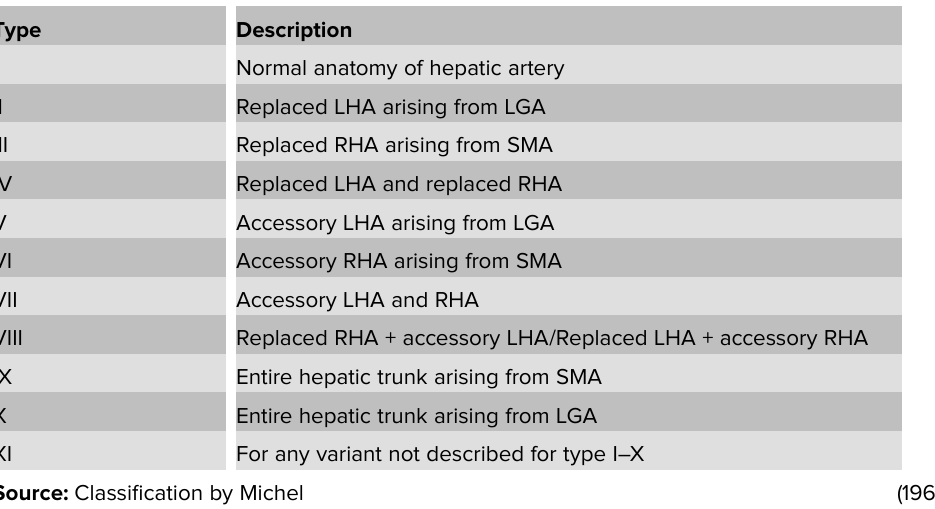
Figure 7 : CT angiography of Toshiba Aquilion 𝑇𝑀 64 slice (Toshiba Medical Systems, Nasu, Japan) showing double hepatic arteries – one arising from the celiac trunk (1) and the other originating as a direct branch from the aorta (2). Table 1: Michel’s classification of hepatic artery